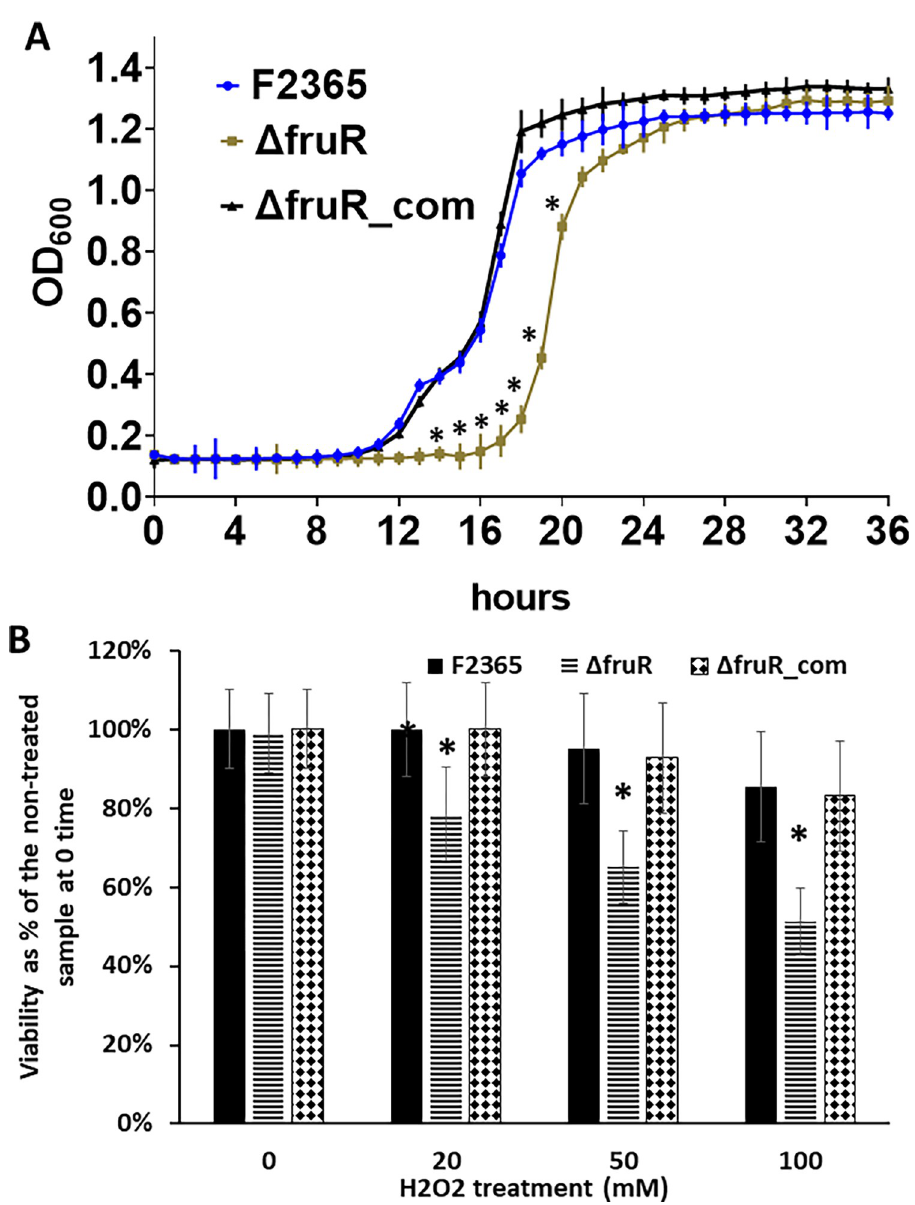
Fig 5. FruR is required for L . monocytogenes response to oxidative stress. (A) The Δ fruR strain has increased lag phase compared to wildtype during growth in BHI broth with 10 mM H 2 O 2 . Growth assays were performed in a 24-well plate and were repeated three independent times with five replicates. Error bars represent SEM. Asterisks mark time points at which OD 600 were significantly different (P < 0.05). (B) Survival of Δ fruR , wildtype (F2365), and complemented ( Δ fruR _com) strains after exposure to H 2 O 2 . L . monocytogenes strains were grown to mid-log phase, resuspended in BHI, and treated with H 2 O 2 . After 1 hour, CFU were enumerated by colony counts on BHI agar plates. Percent survival was calculated by dividing bacterial concentration (CFU/ml) after treatment with H 2 O 2 by the initial CFU/ml for the same strain prior to treatment (time point 0). Data are the mean ± SEM of three experiments with five replicates. At each concentration, Student t-test was used to compare the survival percent. Asterisks indicate significant differences (P < 0.05) compared to the wildtype. downregulated after 4 hours of exposure of L . monocytogenes to carnocyclin A, an antimicro- bial peptide used to control the growth of L . monocytogenes in meat products [62]. Thus, it is probable that DeoR-family proteins, including FruR, have complex regulatory roles in L .